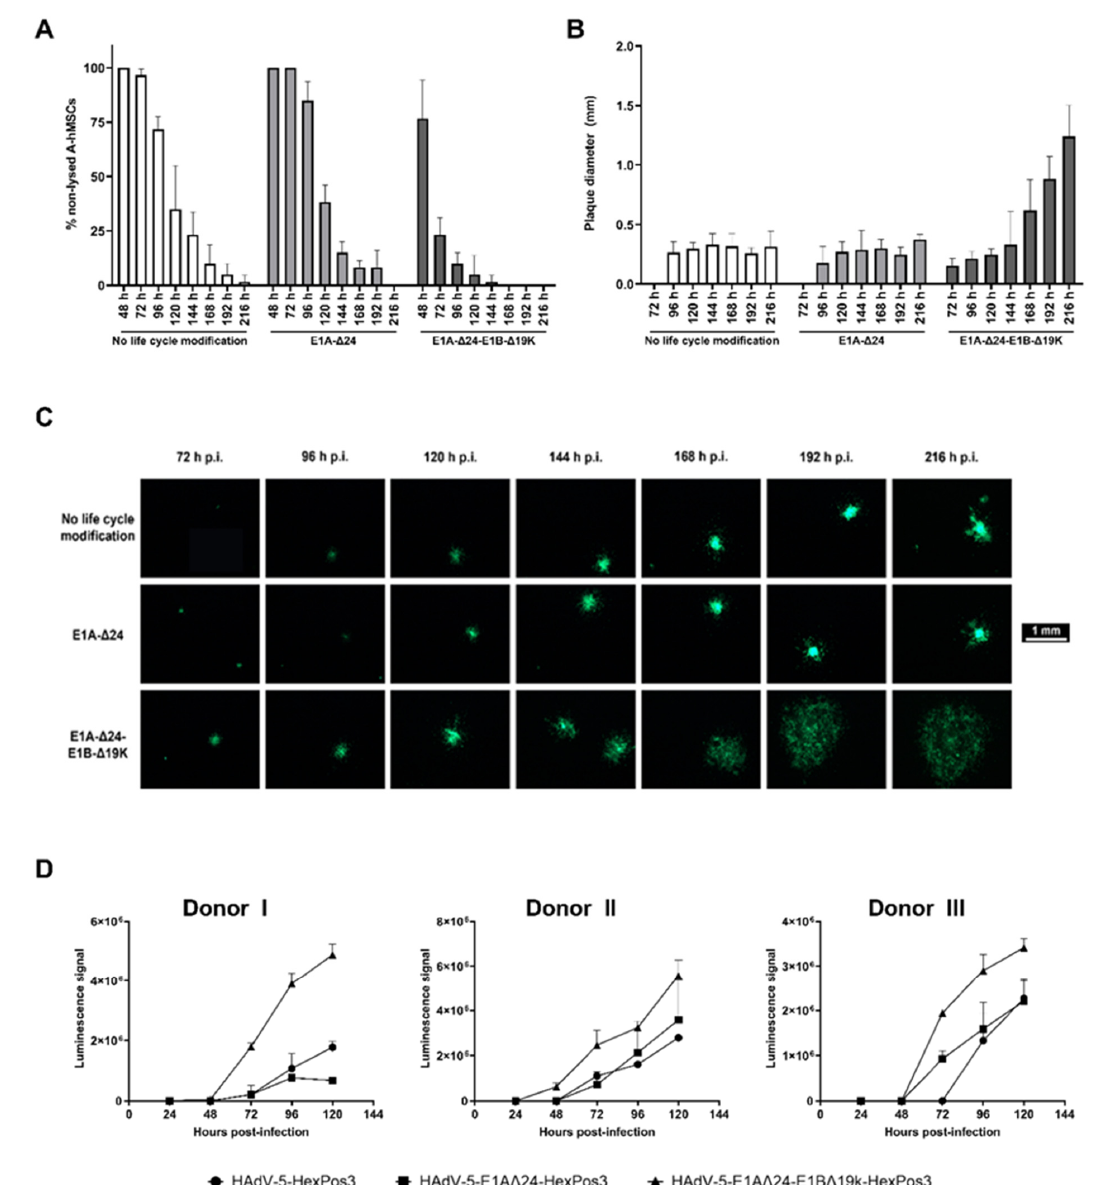
Figure 4. Release of viral progeny upon hMSC infection is significantly accelerated for replication ‐ competent E1B ‐Δ 19K ‐ modified HAdV ‐ 5 ‐ HexPos3 vectors. ( A , B ) Human MSCs infected with an eGFP ‐ expressing, replication ‐ competent HAdV ‐ 5 ‐ HexPos3 vector with the indicated life cycle modification (pMOI 900) were co ‐ cultured with UD ‐ SCC ‐ 2 cells. Every day, the % of non ‐ lysed hMSCs was determined by setting the number of single cells (= non ‐ lysed cells) and the number of plaques visible under the fluorescence microscope in proportion (( A ) mean ± standard deviation of biological triplicates). Moreover, the diameter of the occurring plaques was determined daily (( B ) median ± interquartile ranges of biological triplicates). Representative results from one out of three A-hMSC donors are shown. ( C ) Example images of plaques in hMSC/UD-SCC-2 co-cultures. ( D ) hMSCs were infected with the indicated eGFP-expressing, replicating virus (pMOI 900). Starting after 24 h, the amount of LDH in the cell culture supernatant was determined using the LDH-Glo ® Cytotoxicity assay. Luminescence signals detected in samples of A-hMSCs infected with the indicated replication-competent HAdV-5-HexPos3 vector are shown as mean ± standard deviation of biological triplicates. All experiments were additionally performed with BM-hMSCs from three different donors leading to comparable results (data not